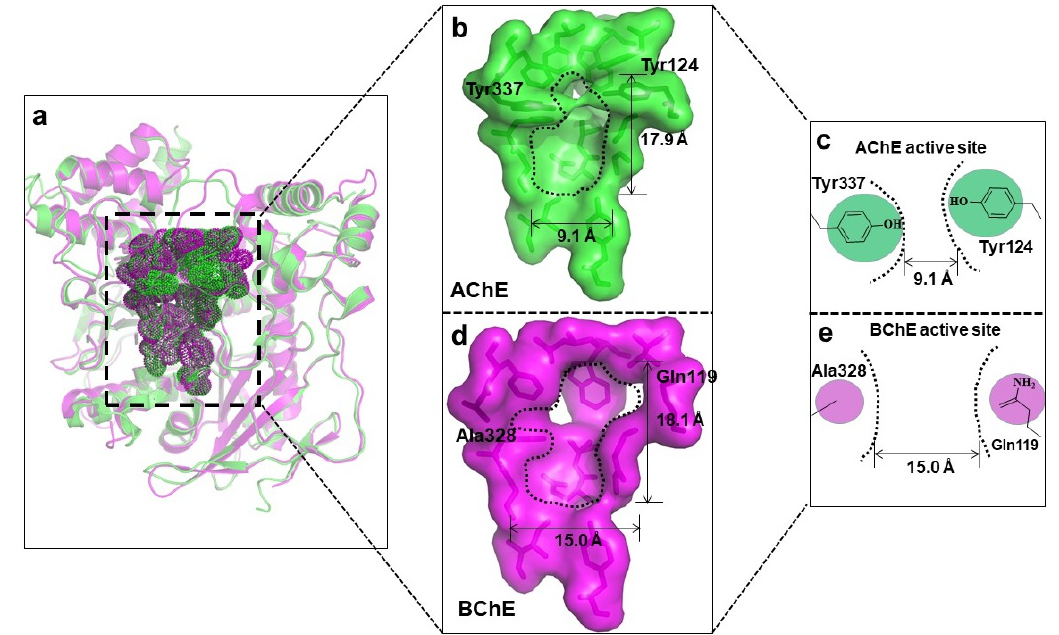
Figure 2. ( a ) The superimposition of the crystal structures of AChE (in green) and BChE (in purple). ( b ) The surface view of AChE and the active site is circled with a black dash line. ( c ) The size of the middle part of the AChE active site. ( d ) The sphere view of BChE and the active site is circled with a black dash line. ( e ) The size of the middle part of the BChE active site.